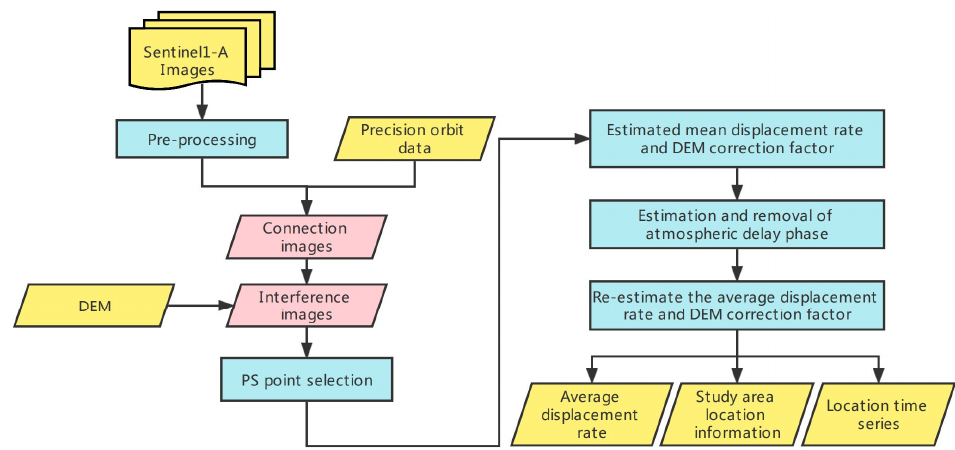
Figure 2. Illustrates the processing flow of PS-InSAR.